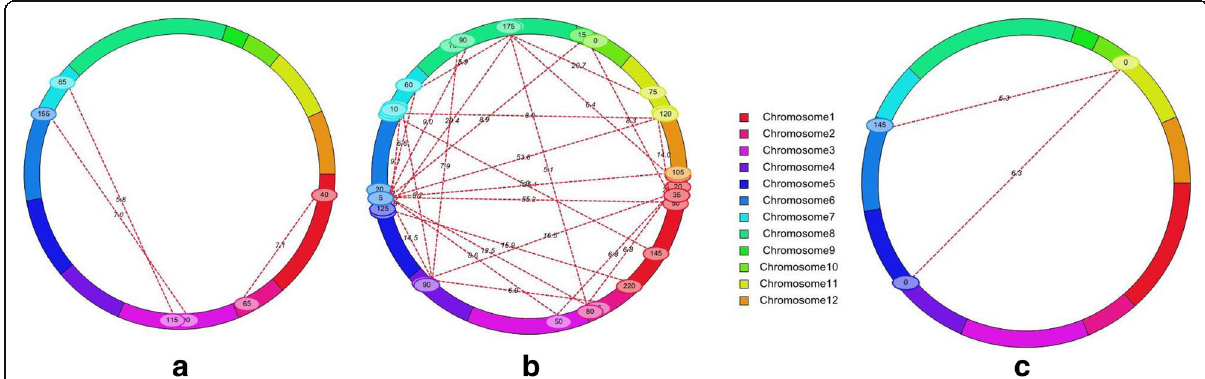
Fig. 3 Cyclic illustrations of epistatic QTLs for salt tolerance indices: ( a ) shoot fresh weight, ( b ) shoot dry weight, and ( c ) SES score with QTL × environment interactions on linkage groups by ICIM. The dotted lines indicate the interacting marker pairs located on the same or different chromosomes with corresponding LOD score due to epistatic effect. Chromosomes 1 (40 cM) and 2 ( qFWsht2.1, 65 cM) showed interaction between QTL and background loci for shoot fresh weight ( b ), whereas chromosomes 1 (35 cM) and 4 (95 cM) showed interaction between complementary loci for DWsht (see Table